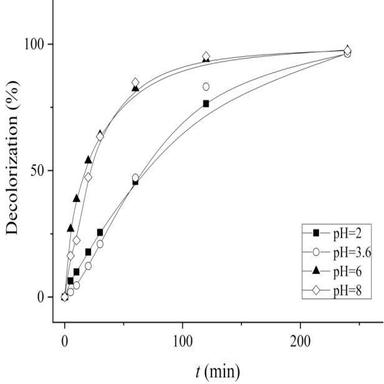
Decolorization of tartrazine solution monitored at λ = 426 nm during reaction at different initial pH values of the reaction mixture at 50 °C, mcat = 5 mg.